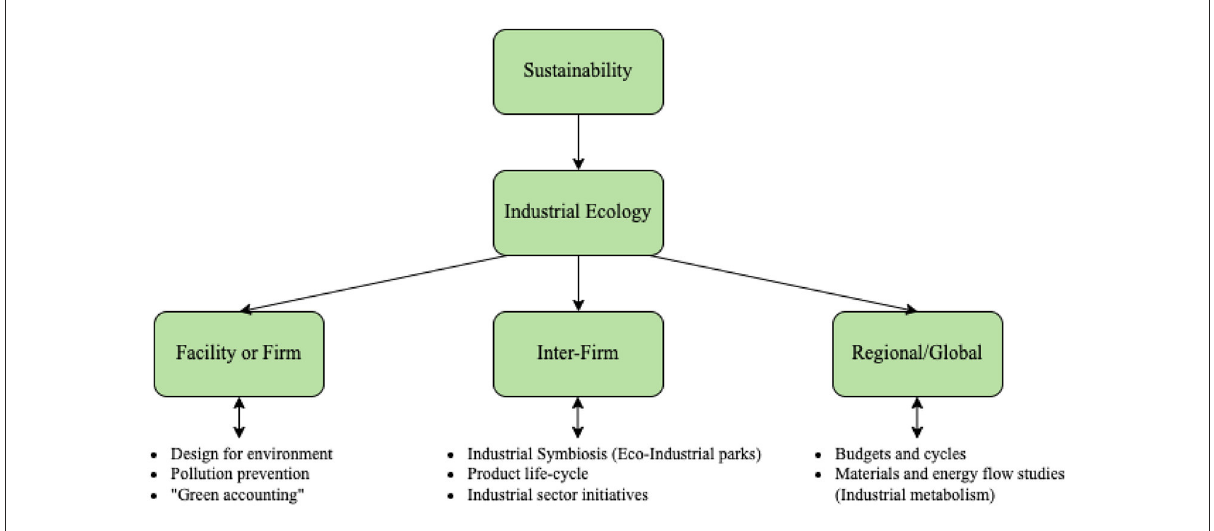
FIGURE1 Industrial ecology structure. Source: Chertow